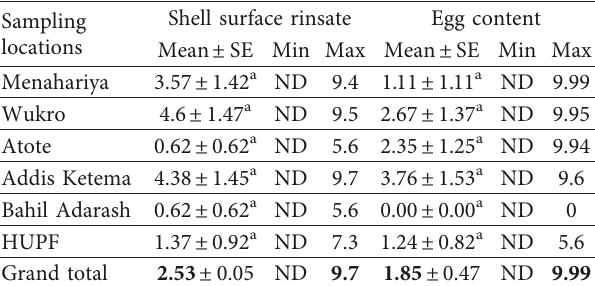
Table 6: Total coliform count (TCC) in log surface rinsates and contents of egg samples in Hawassa City, southern Ethiopia, 2019.